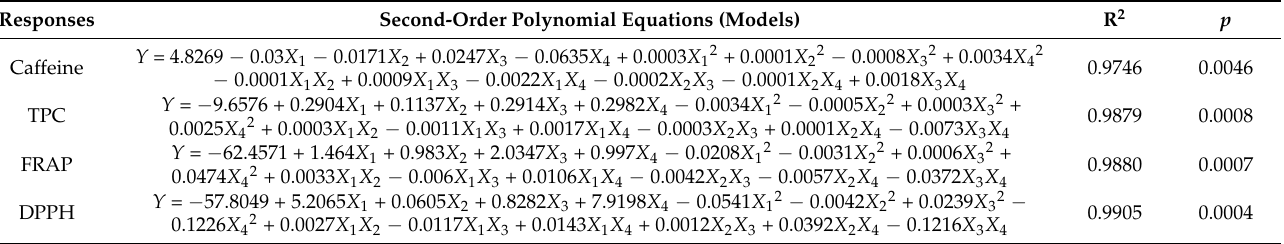
Table 3. Mathematical models created using the response surface methodology used to optimize the hydroethanolic solution extraction of used coffee grounds; the models contain only significant